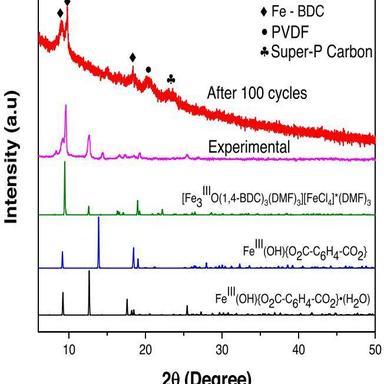
Ex-situ XRD patterns of experimental simulated from CIFs and after 100 cycles (green = Phase 1, blue = Phase 2, black = Phase 3).